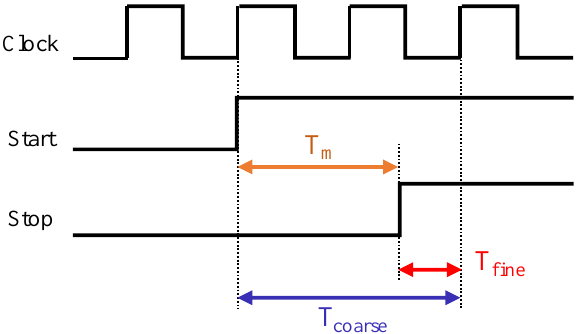
Figure 1. Synchronous Coarse–Fine TDC principle. T m can be measured as a subtraction of two components, T coarse and T fine .